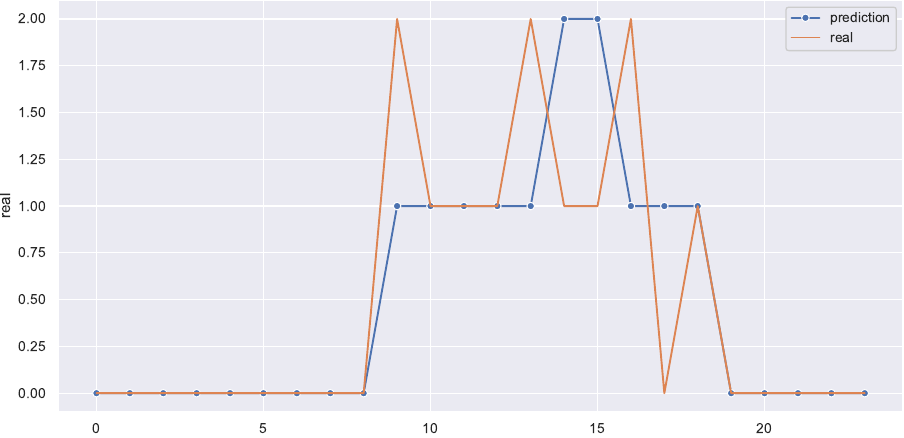
Figure 11. The framework predictions for multi-level occupancy versus reality (24 h ahead).